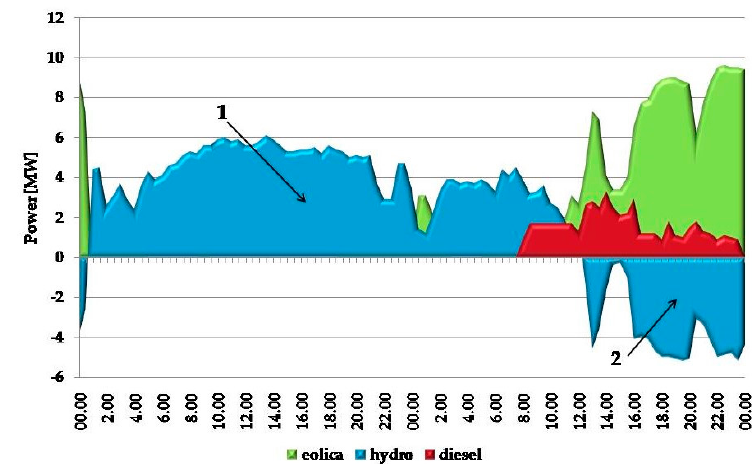
Figure 10. Operation of a hydroelectric plant in a windless period on 28–29 March 2018. Own study based on data from Red El é ctrica de España. Monitoring REE (Red El é ctrica de España) was carried out at 10-min intervals [58]. For the purpose of this work, the graphical relationship is shown in half-hourly intervals. Signs: (1) water power, and (2) water in the bottom tank (required wind to be pumped into the upper tank).